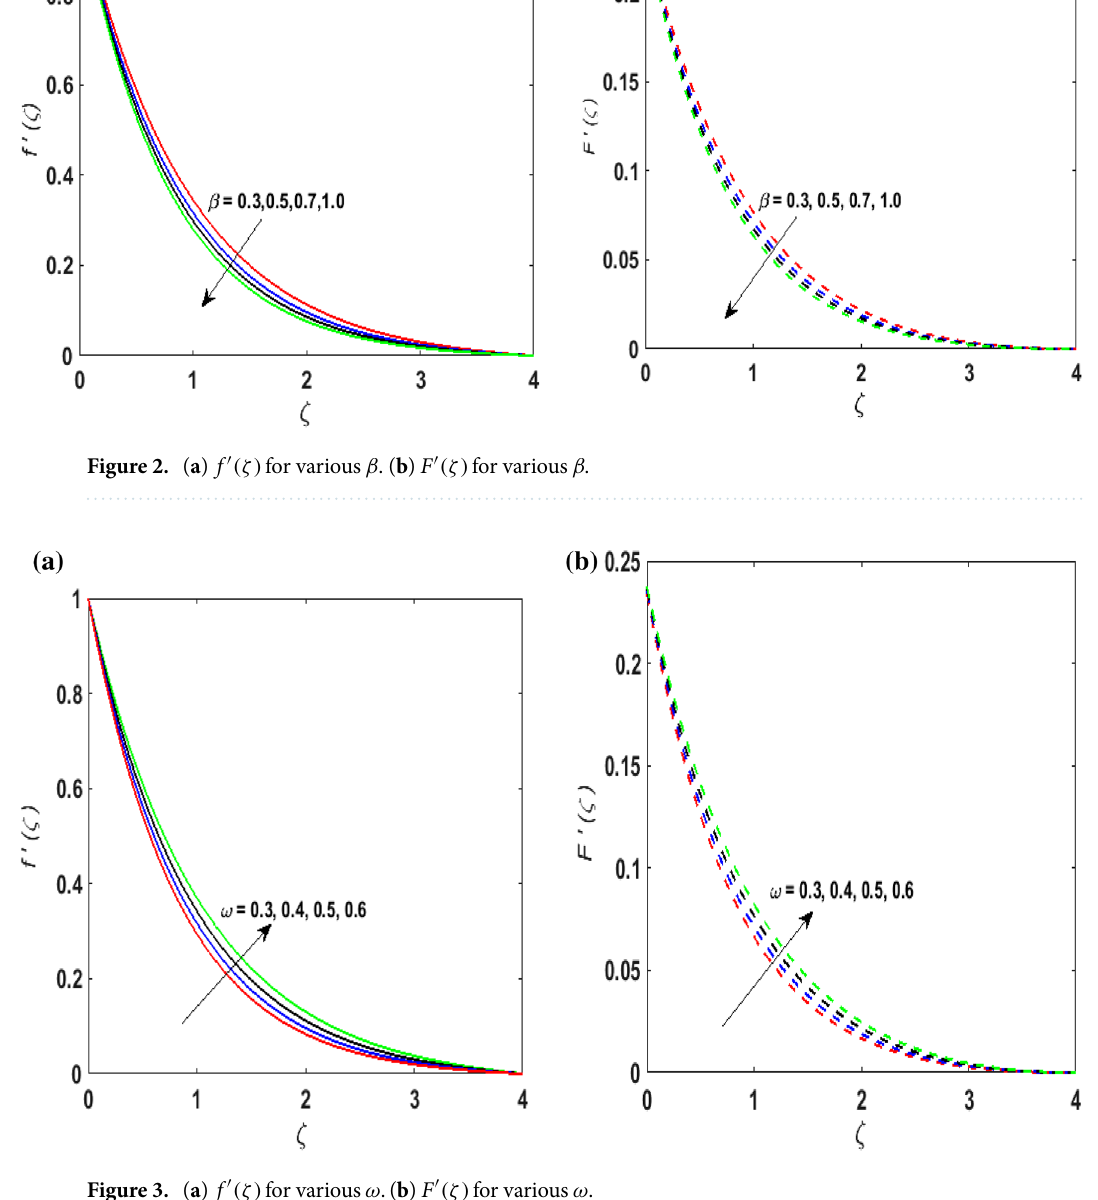
Figure 3. ( a ) f ′ (ζ) for various ω . ( b ) F ′ (ζ) for various ω